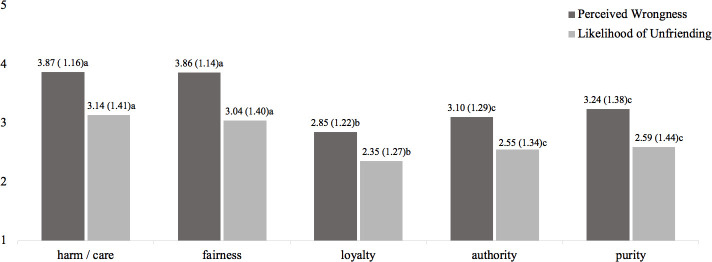
Effects of scenario manipulation on perceived wrongness and unfriending likelihood in different moral domains/ means and standard deviations in parentheses (Study 1).Note. Different subscripts in a row indicate significant differences with p < .05 using Bonferroni-corrected post hoc comparisons.